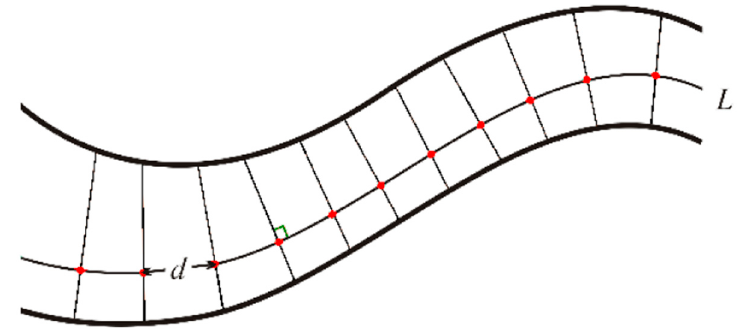
Figure 2. Sectioning point cloud data.